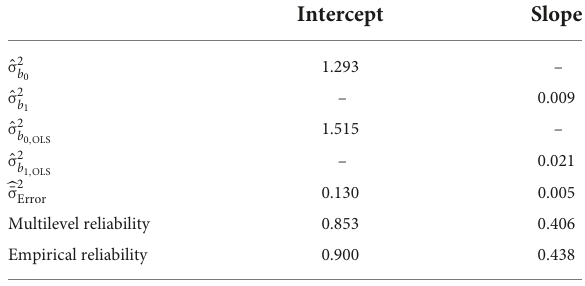
TABLE 2 Reliability estimates at the student level and at the class level.